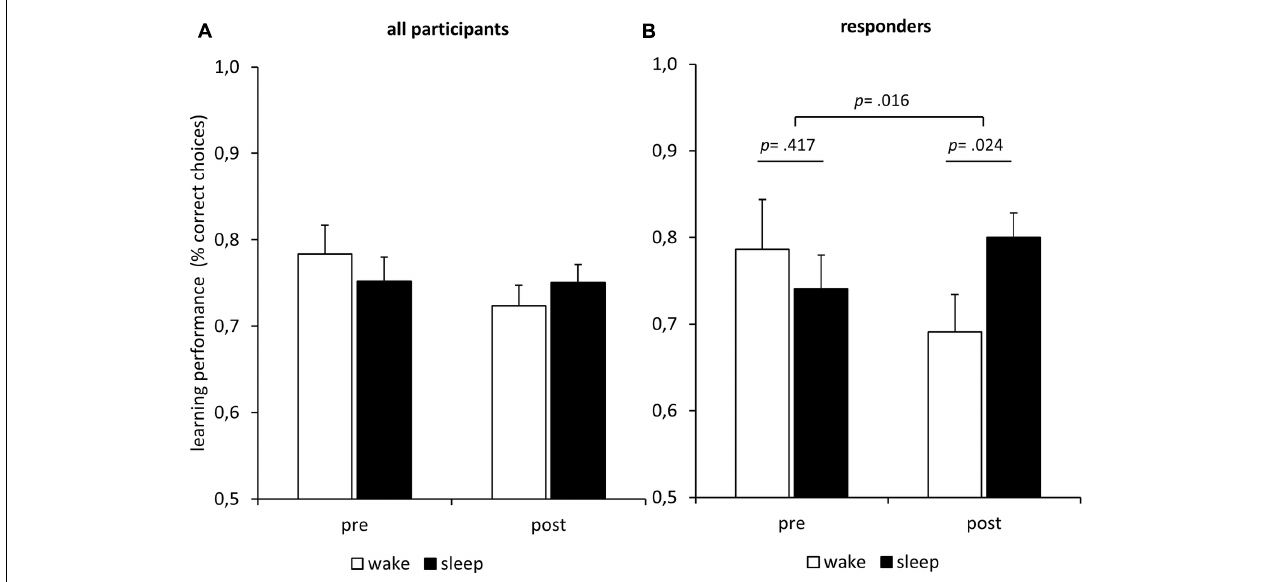
FIGURE 3 | Influence of sleep/darkness on feedback learning. (A) Learning performance (mean ± SEM) improved during the interval irrespective of condition. Note that the guessing frequency is 0.5 correct choices. (B) Only in the melatonin responders ( n = 11) did learning performance increase more during sleep in darkness than during wake in bright